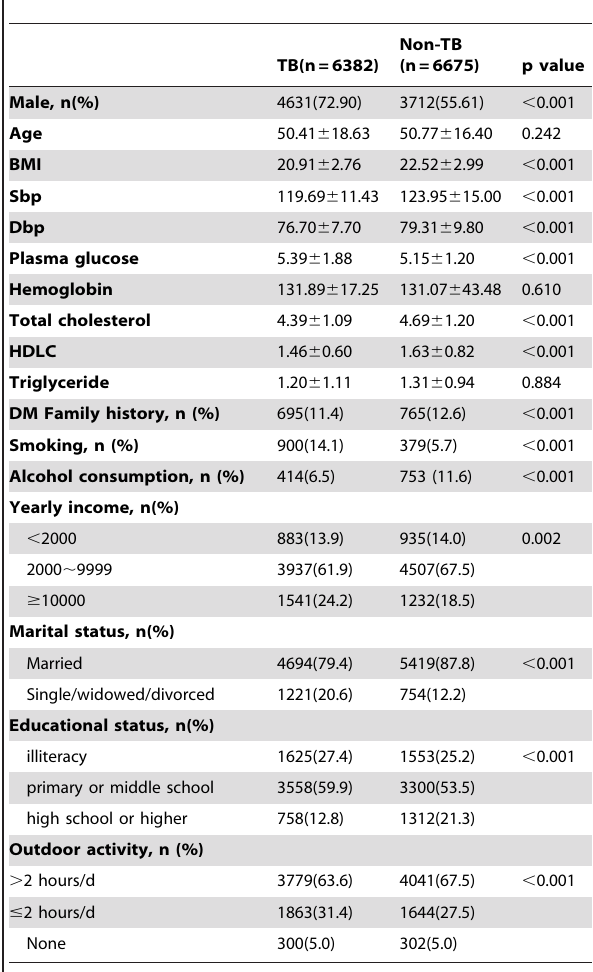
Table 1. Characteristics of TB patients and non-TB controls, Linyi,